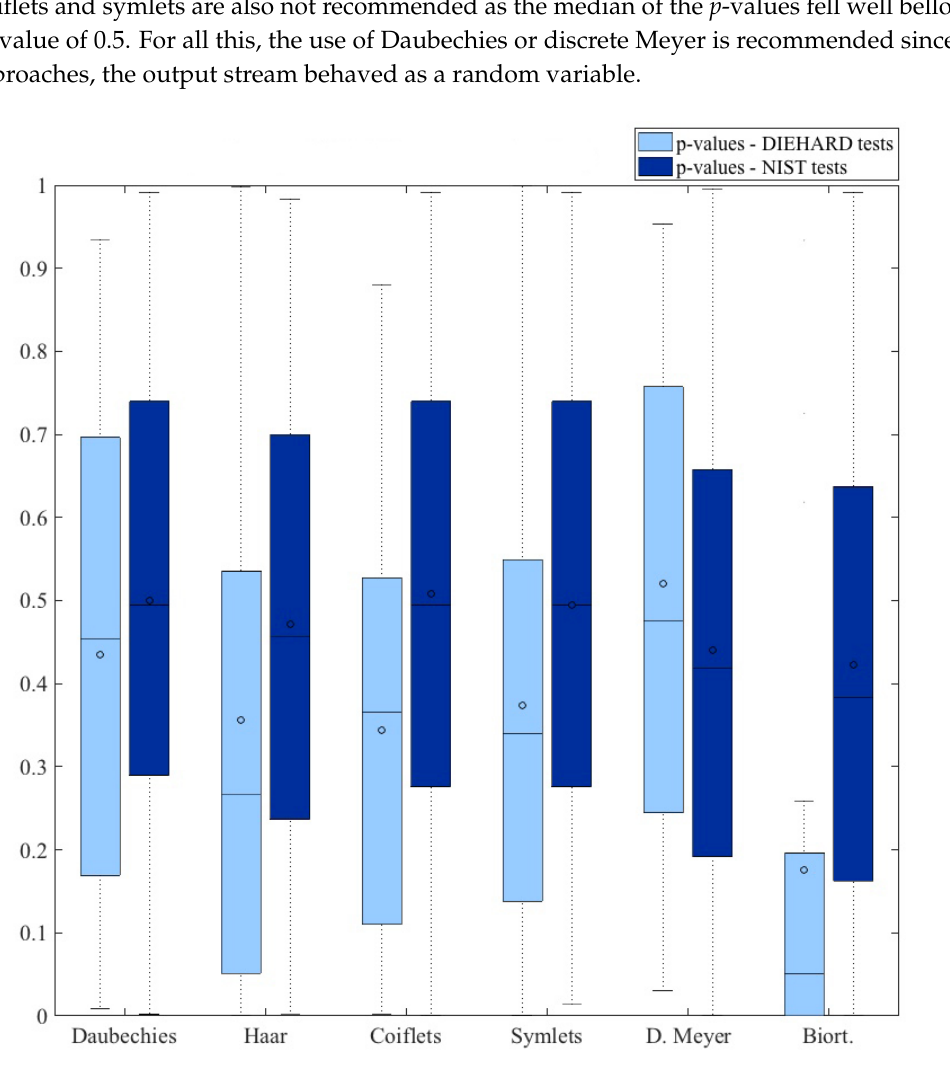
Figure 7. p -values (DIEHARD and NIST suite